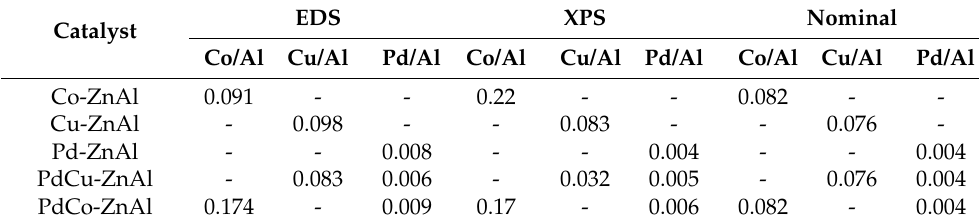
Table 2. Nominal, EDS-SEM and XPS-derived surface atomic ratios of